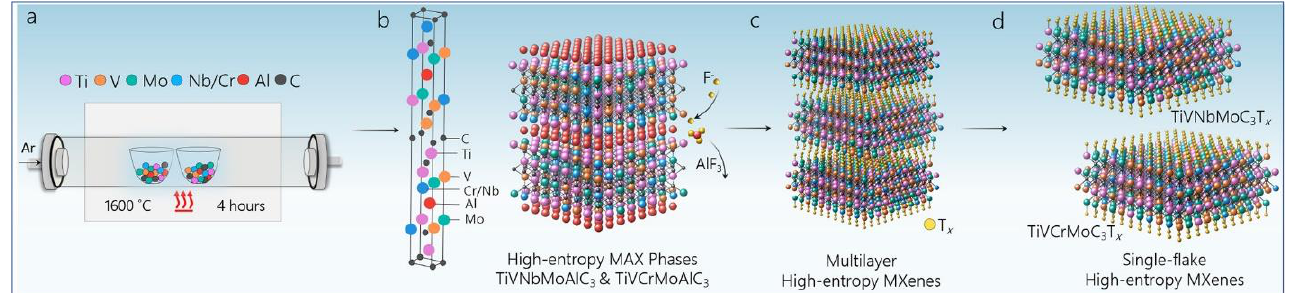
Figure 5. Schematic for the synthesis of MAX and MXenes. ( a ) Reactive sintering of high-entropy MAX phases. ( b ) MAX phase unit cell (left) of M 1 M 2 M 3 M 4 AlC 3 with elements Ti (pink), V (orange), Nb or Cr (blue), Mo (green), Al (red), and C (black). The synthesized MAX phases with layered transition metal layers are composed of four transition metal elements, with aluminum (red) and carbon (black) atomic layers in an M 4 AlC 3 MAX structure (right). ( c ) Selective etching of the Al layers by hydrofluoric acid to synthesize multilayer high-entropy MXenes. ( d ) Delamination of multilayer MXenes is completed via organic molecule intercalants, which leads to the formation of single flakes of high-entropy MXenes TiVNbMoC3Tx and TiVCrMoC3Tx. Adapted with permission [11]. Copyright 2021, American Chemical